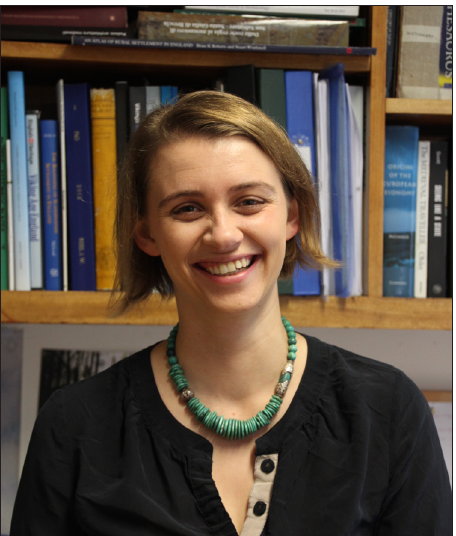
Figure 1: Corisande Fenwick (Photo Lisa